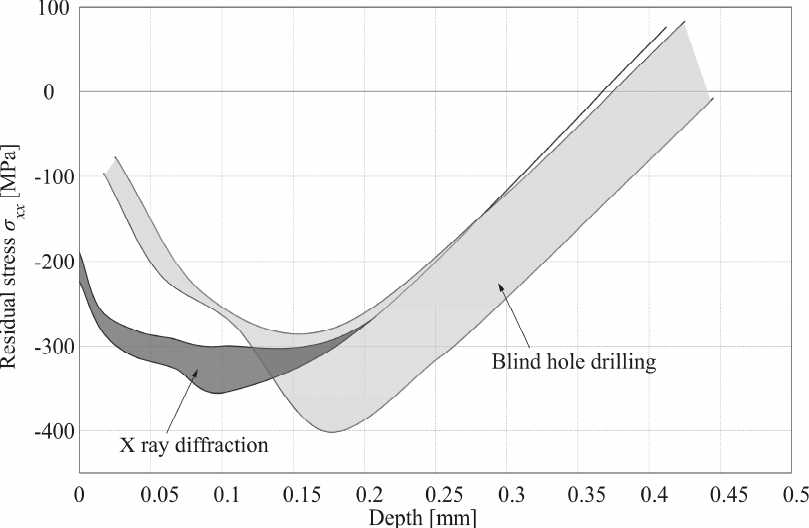
Figure 4. Measured residual-stress distributions in shot-peened dog–bone test specimens.